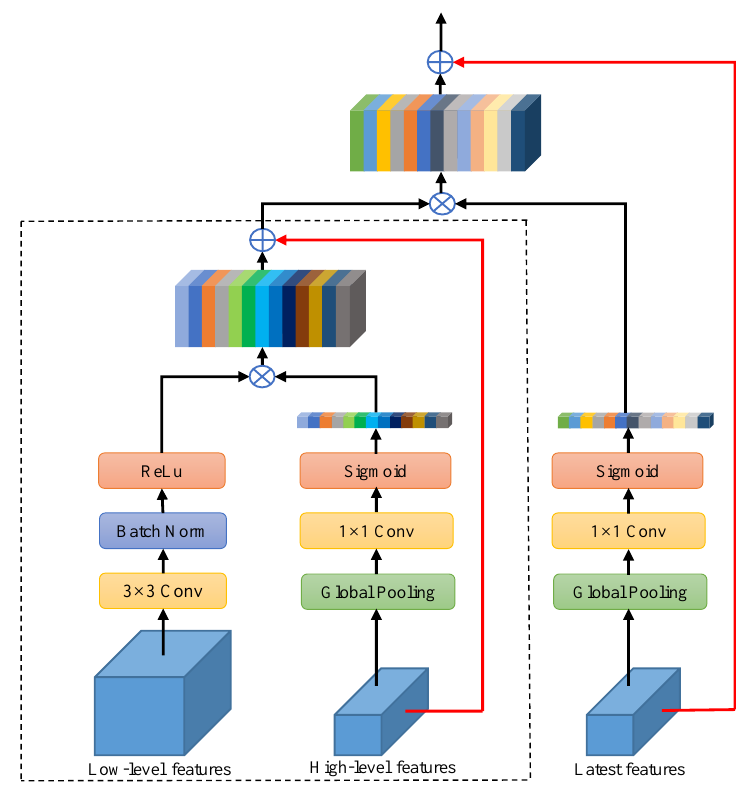
Figure 3. The structure of Multi-level Feature Attention Upsample